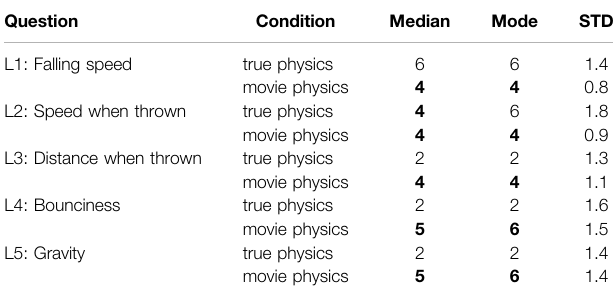
TABLE 3 | Summary of Likert data in Study 1. In L1 – L3, responses closer to 4 are perceived as closer to realism, whereas in L4 and L5, responses closer to 7 are perceived as closer to realism. Responses perceived closer to realism are emphasized in bold (Pouke et al.,